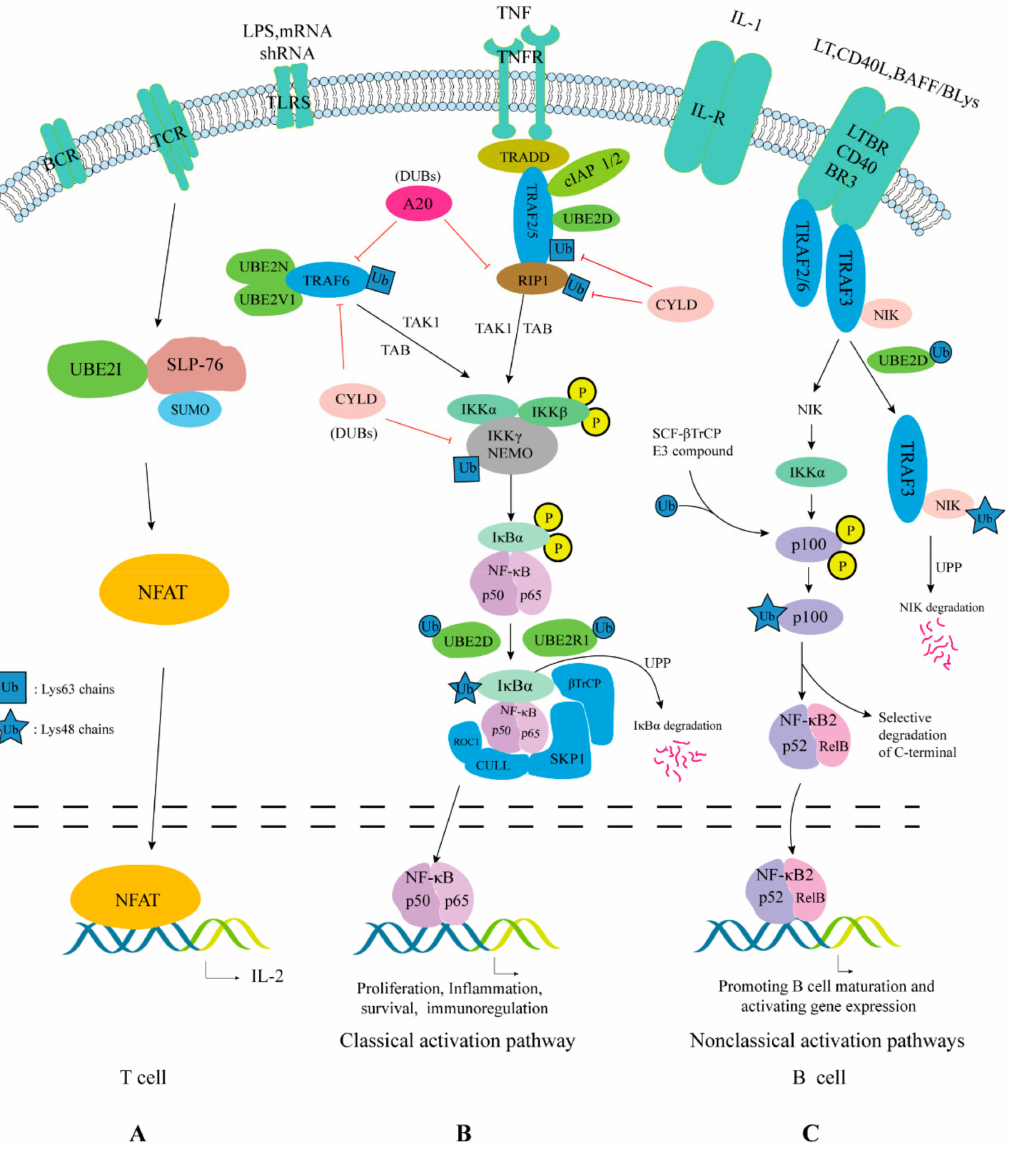
Figure 5. E2s participate in the NF- κ B pathway. ( A ) T cell receptor (TCR) stimulation promotes the binding of SLP-76 and UBE2I and increases the SUMOylation of SLP-76. SLP-76 and UBE2I synergize to augment TCR-mediated IL2 transcription by nuclear factor of activated T cells (NFAT) in a manner dependent on SUMOylation of SLP-76 [232]. ( B ) Under the action of the stimulation signal, I κ B α will rapidly undergo phosphorylation modification under the stimulation of IKK. IKK contains two catalytic subunits, IKK α and IKK β , and one regulatory subunit IKK γ [225]. In the classical pathway, IKK β phosphorylates I κ B α and is then recruited into the SKP1/CUL1/F-box protein (SCF) complex via β TrCP containing the F-box domain. β TrCP contains a WD40-repeat domain, which can specifically bind to two phosphorylated serine sites